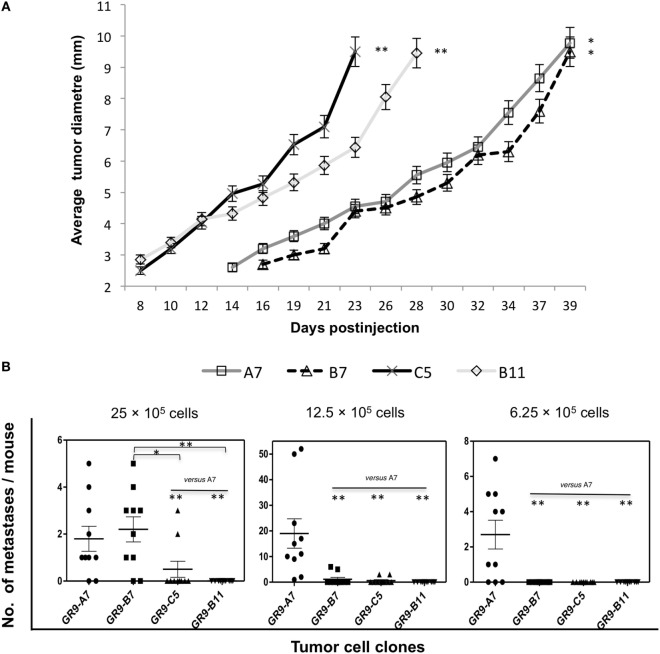
(A) Cell lines with different patterns of H-2 class I expression show distinct local oncogenicity. Tumor clones were injected (6.25 × 105 cells) into the footpad of male BALB/c mice. The tumor diameter was measured three times/week and removed when it reached 10 mm. H-2 class I-positive tumors, GR9-A7 and -B7, grew more slowly than the more negative tumors GR9-C5 and -B11. The mean ± SD tumor diameter of 10 mice is shown as a function of time. (B) Spontaneous metastasis assays with GR9-A7, -B7, -C5, and -B11 tumor clones. Four different cell doses (50 × 105, 25 × 105, 12.5 × 105, and 6.25 × 105 cells) were injected into the footpad of 10 mice each. The number of metastases per mouse was counted. GR9-B11 clone (MHC-I-negative) did not generate metastases at any tumor cell dose. GR9-A7, -B7, and -C5 clones all generated metastases. GR9-A7 clone (MHC-I-positive) showed the highest metastatic capacity (range, 1–52 metastases per mouse). *p < 0.05; **p < 0.01. Kruskal–Wallis test, followed by Dunn post hoc test was used for statistical analysis.